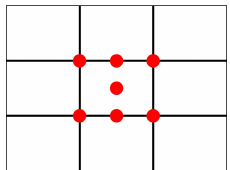
Figure 14. The reference positions to consider a vanishing